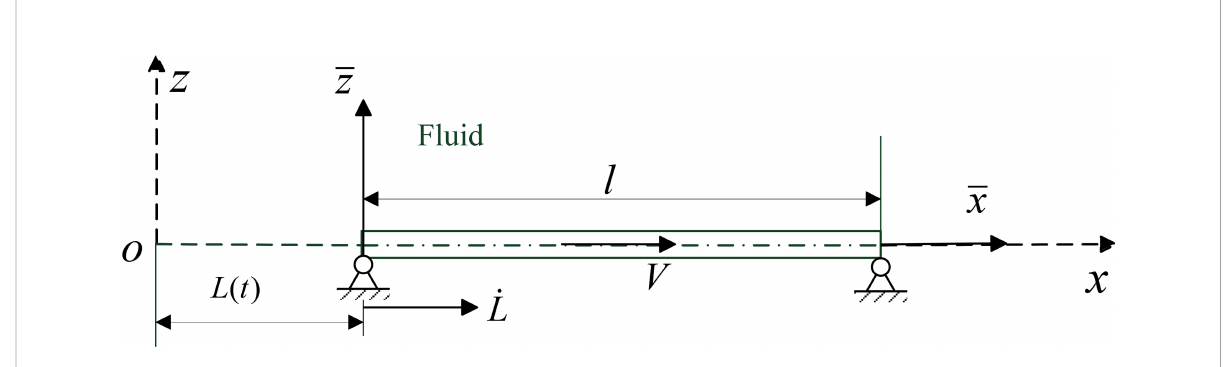
FIGURE 2 The analysis system and the corresponding